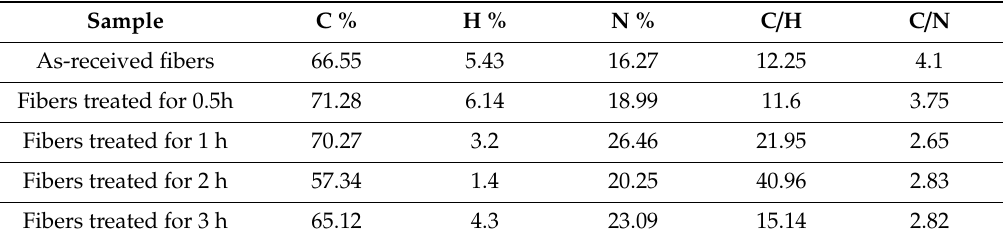
Table 3. Elemental Analysis of as-received fibers and thermally stabilized